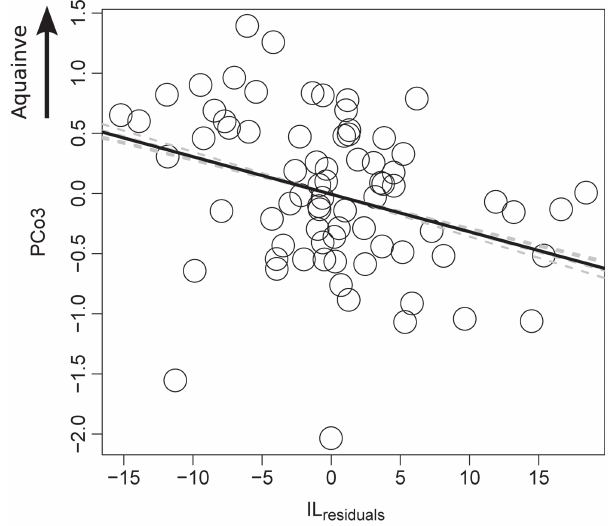
Fig. 6. Relationships between diet composition of Deuterodon stigmaturus summarized by the PCo3 of a Principal Coordinate Analysis (PCoA) and intestine length independent of standard length (IL ). Higher PCo3 residuals values indicate a greater proportion of aquatic invertebrates ingested by individuals. Sampling months (dashed lines) were used as random effect variable and IL was used residuals as a fixed effect (solid line) variable to fit a linear mixed- effects